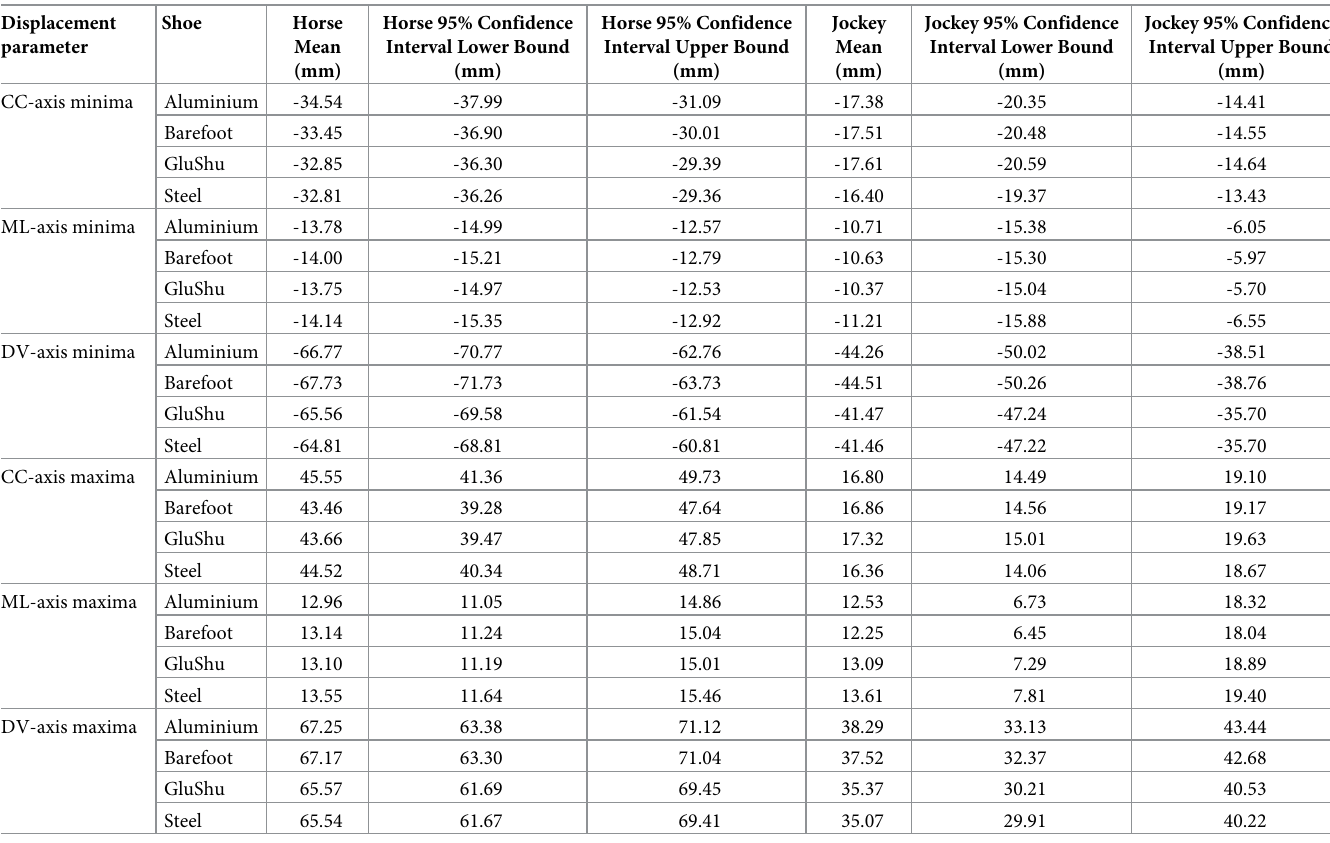
Table 4. Estimated marginal means and confidence intervals for shoe effects. Displacement